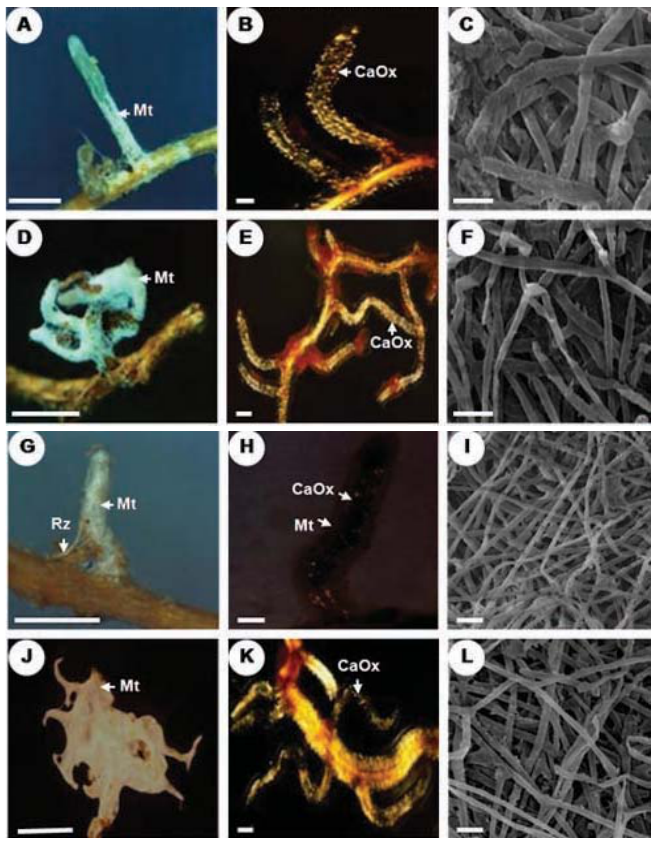
Figura 2. Morfologia de ectomicorrizas de híbrido de Eucalyptus grandis x Eucalyptus urophylla , coletadas no topo de área com topografia típica em meia laranja, de vertente côncavo-convexa, e observadas por microscopia óptica (A, D, G, J); por microscopia óptica de luz polarizada, para visualização de cristais de oxalato de Ca (CaOx). (B, E, H, K); e por microscopia eletrônica de varredura (C, F, I, L). As três fotos horizontais correspondem a um morfotipo distinto. Os CaOx aparecem como pontos brilhantes nas estruturas diafanizadas. Observar manto micorrízico (Mt), rizomorfos (Rz) e diferenças na distribuição de CaOx entre os diferentes morfotipos de ectomicorriza. Barras: A, D, G e J = 1 mm; B, E, H e K = 200 μμμμμ m; C = 3 μμμμμ m; F = 5 μμμμμ m; I = 20 μμμμμ m; L = 10 μμμμμ